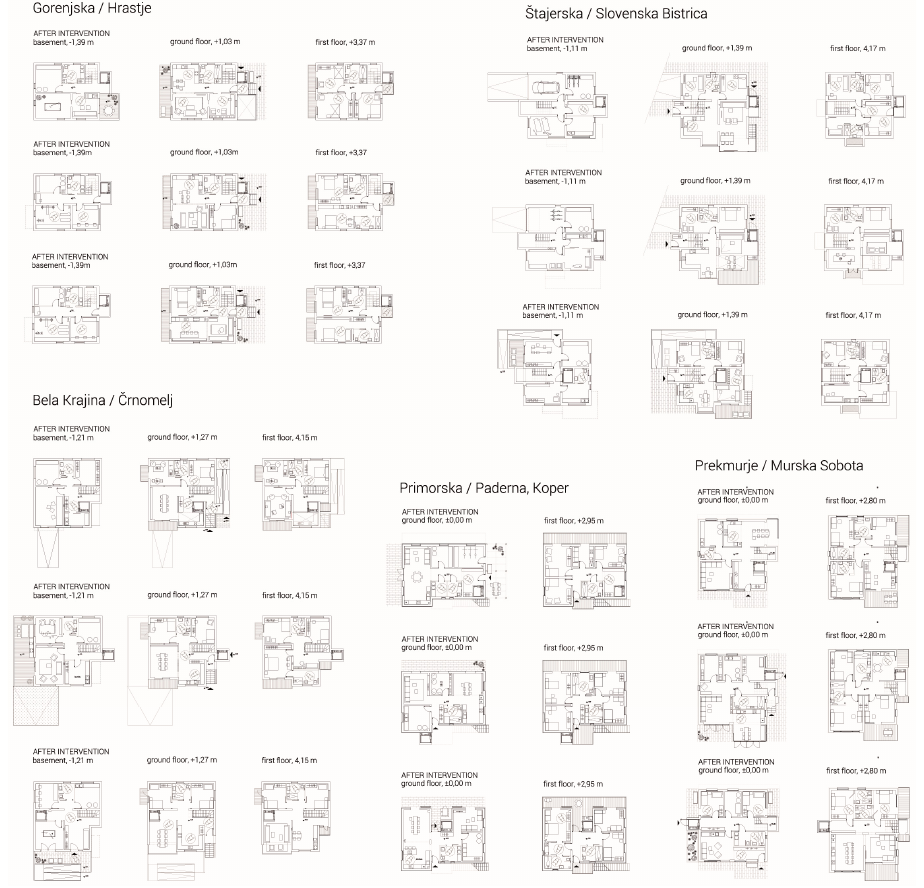
Figure 7. The corpus of 15 solutions designed for five different type-houses in different locations (Ana Bel č i č , 2022).